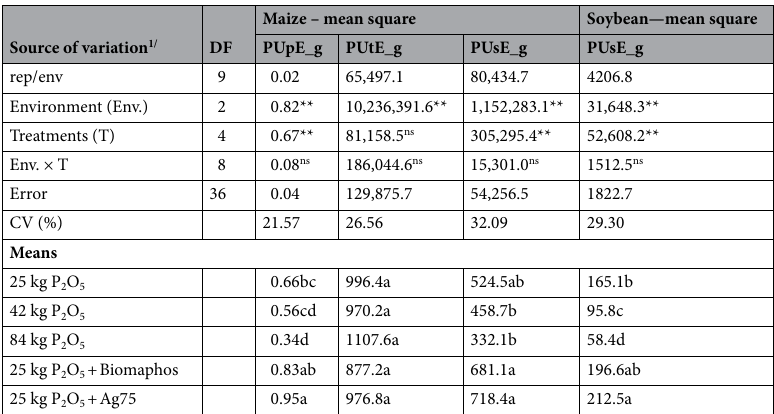
Table 2. Analysis of variance and Tukey’s test for phosphorus uptake efficiency (PUpE_g), phosphorus utilization efficiency (PUtE_g), and phosphorus use efficiency (PUsE_g) in maize and soybean experiments with seeds inoculated with phosphate-solubilizing bacteria. ns , ** and * indicates non-significance, significance at levels 1 and 5% of probability by the F test, respectively. Means followed by different letters on the same line differ significantly from each other as measured by the Tukey test at the significance level of